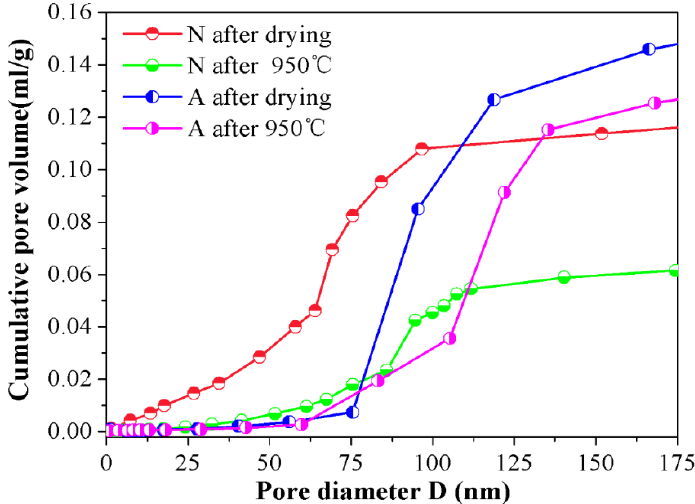
Figure 6. Relationship between cumulative pore volume and pore diameter for samples A and N before and after 950 °C heat treatment.